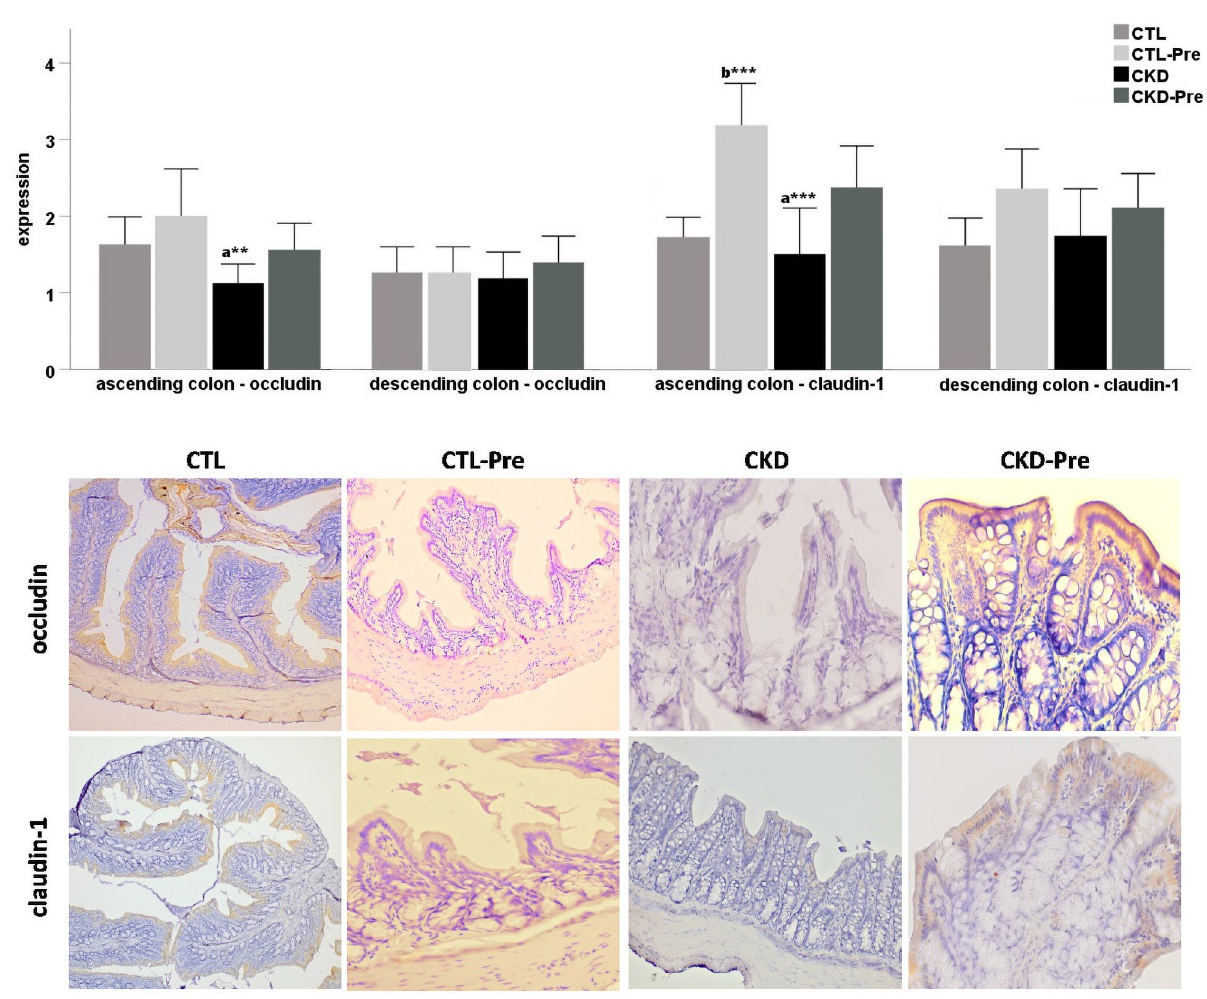
Fig 4. Immunoperoxidase expression of occludin and claudin-1 in the ascending and descending colon of CTL, CTL-Pre, CKD, and CKD-Pre groups. Indirect ABC immunoperoxidase technique, Mayer’s hematoxylin counterstaining. Immunohistochemical staining in all groups was scored semi-quantitatively from 0 to 4. Data are expressed as mean ± SEM. “a” significant difference compared to CTL-Pre group; “b” significant difference compared to CTL group. � p < 0.05; �� p < 0.01; ��� p < 0.001. Representative images showing immunohistochemical staining for occludin and claudin-1 in ascending colon of CTL, CTL-Pre, CKD, and CKD-Pre. Scale bar = occludin: CTL, CTL-Pre 180 μ m, CKD, CKD-Pre 90 μ m; claudin-1: CTL 220 μ m, CTL-Pre, CKD-Pre, 160 μ m, CKD 280 μ